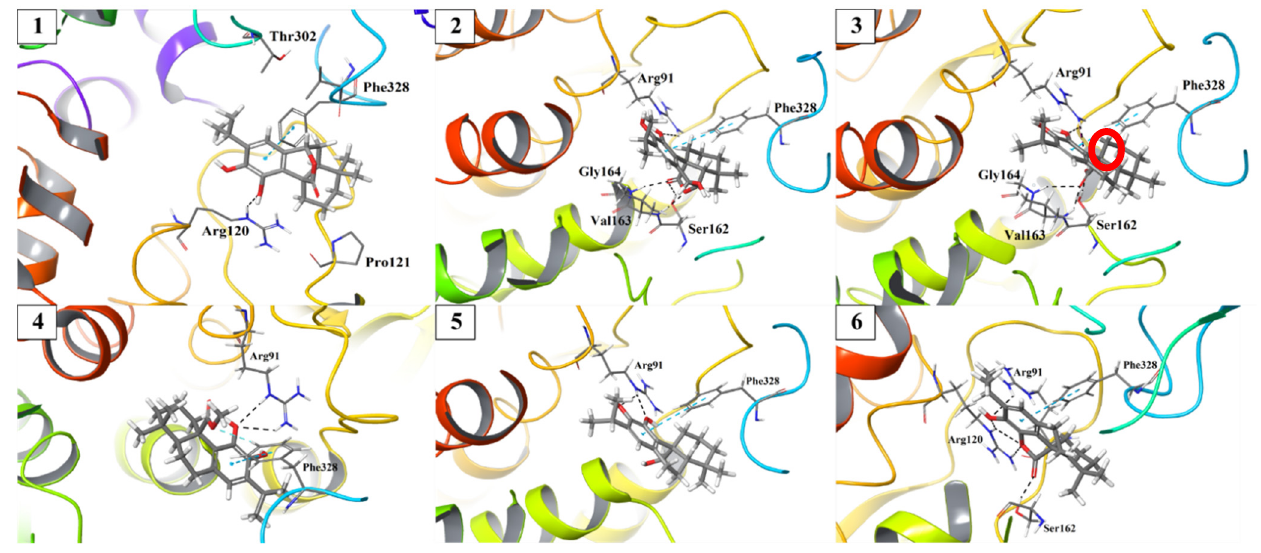
Figure 5. Binding modes of compounds 1 – 6 .